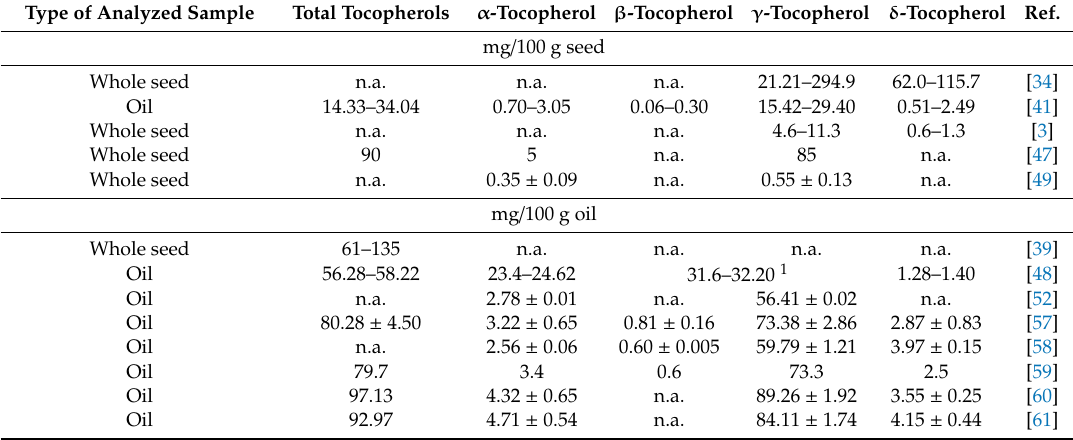
Table 4. Hempseed oil unsaponifiable matter: tocopherol